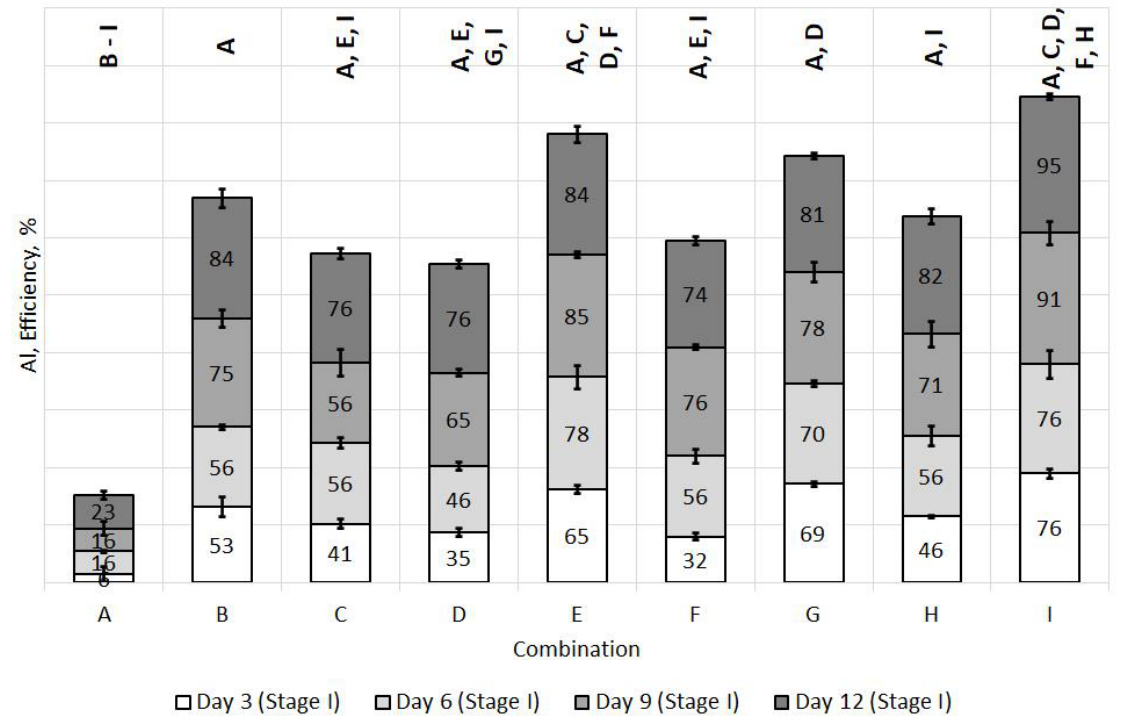
Figure 5. Effectiveness of Al release to the dissolved fraction of leachate (Stage I).